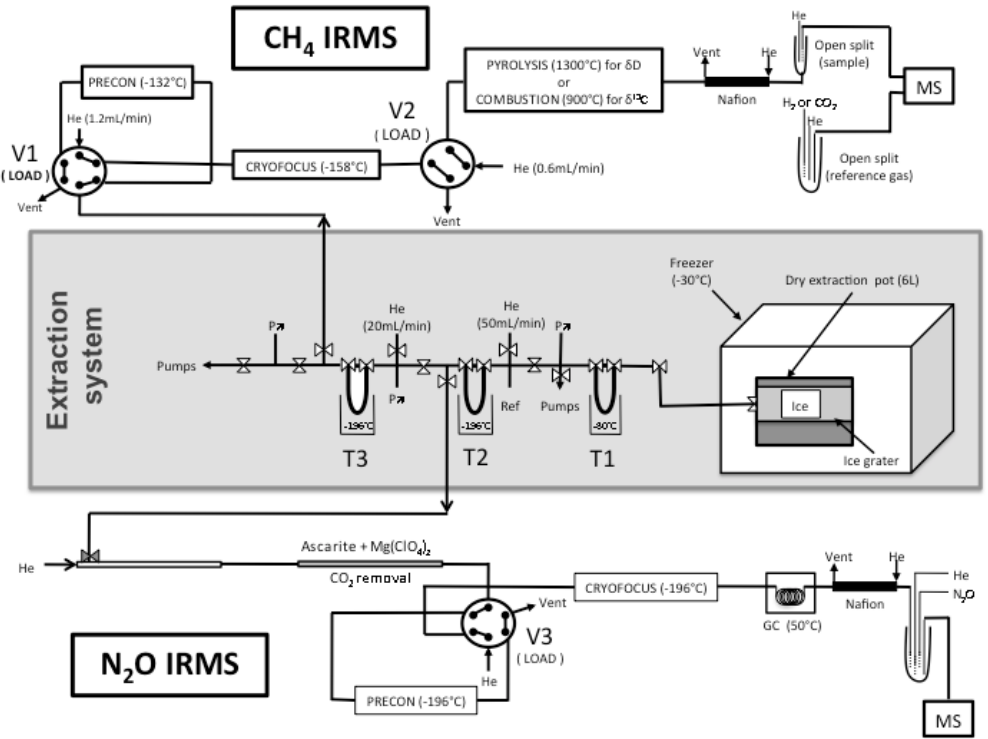
Fig. 1. Schematic set-up of the analytical system. The extraction system in the shaded box in the center consists of a glass line (12mm o.d.) with manual valves. The connection between this glass line and the ice grater is made via a piece of flexible stainless steel bellows tubing. T1, T2 and T3 represent, respectively, a water trap, a CO 2 /N 2 O trap and a Hayesep trap where CH 4 and air are adsorbed. V1, V2 and V3 represent multiport two-position Valco valves.